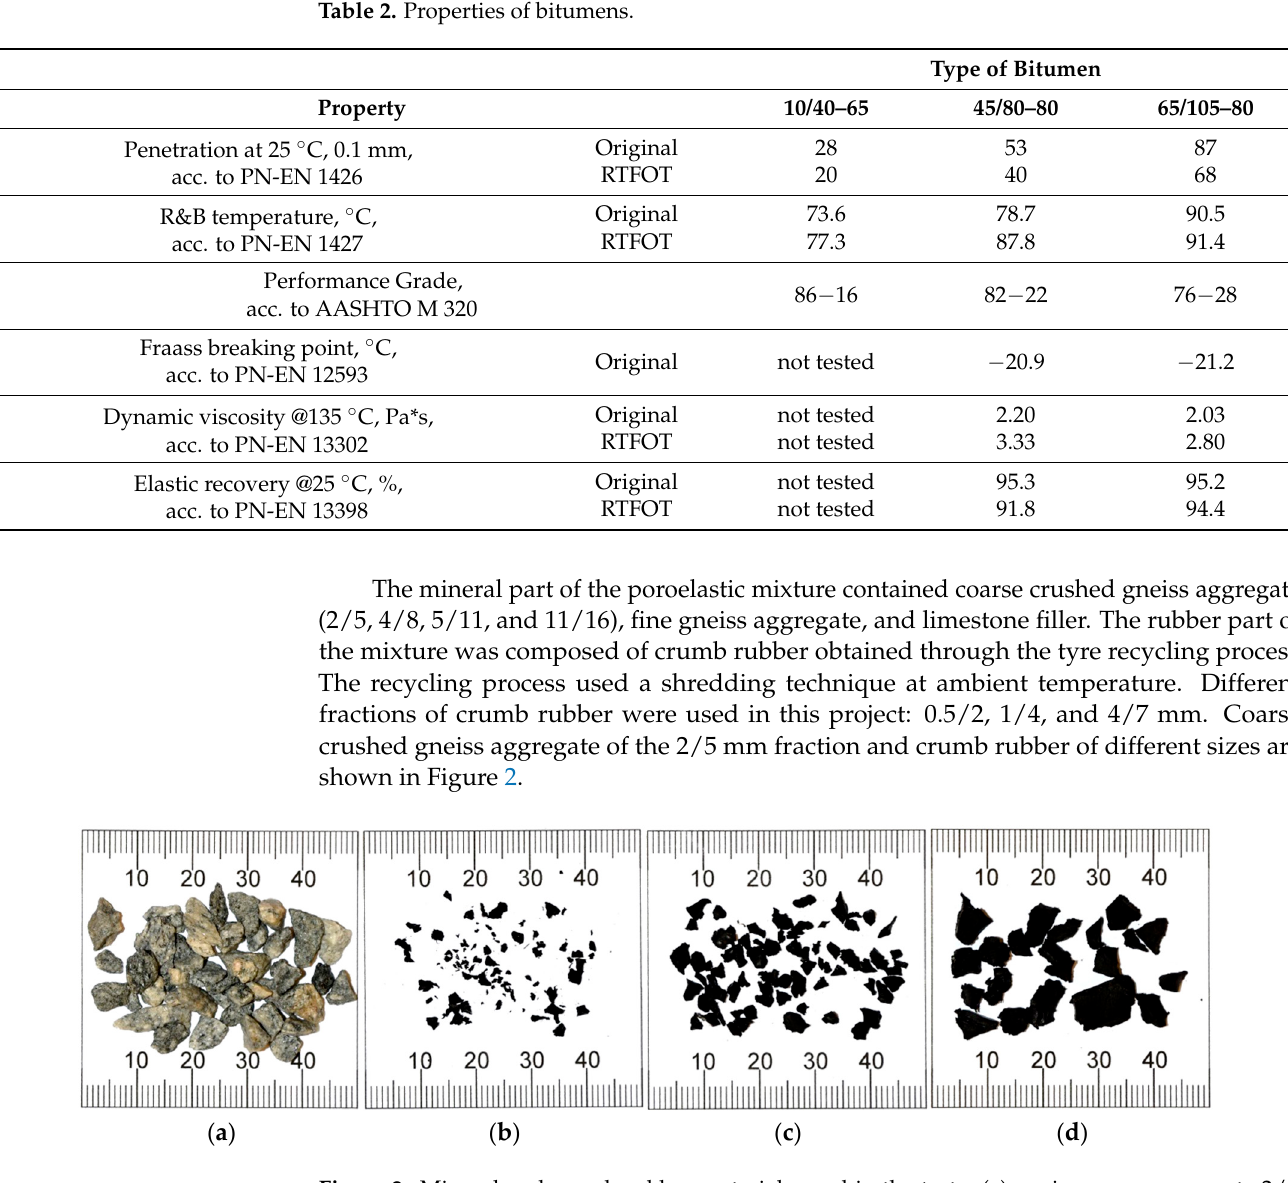
Figure 2. Mineral and crumb rubber materials used in the tests: ( a ) gneiss coarse aggregate 2/5; ( b ) crumb rubber 0.5/2; ( c ) crumb rubber 1/4, and ( d ) crumb rubber 4/7. During the initial stage of laboratory testing, two additional modifications of the production process were also tested: using polymer fibres as reinforcement and additional modification of bitumen with crumb rubber. Two types of fibres were investigated. One type was aramid-polyalphaolefin fibre, which is produced specifically for use as reinforcement in asphalt mixtures. In this research two lengths of these fibres were used: 19 mm and 38 mm. The fibres were added at the quantity of 0.05% by weight of asphalt mixture. The second type of fibre was 50-mm-long polymer fibre, used normally as reinforcement for cement concrete mixtures, at the quantity of 0.05% by weight of asphalt mixture. An additional crumb rubber modification method was conducted in the laboratory using a special crumb rubber additive technology. This process consisted of mixing 191 g of ground tyre rubber (0.2/0.8 mm), 9 g of a specific polymer (polyoctynamer), and 2000 g of asphalt binder. The mixing process was performed using laboratory mixer at 200 RPM for 120 min. Temperature during the mixing process was kept within the range of 170–180 ◦ C. Different additives used in the tests are shown in Figure